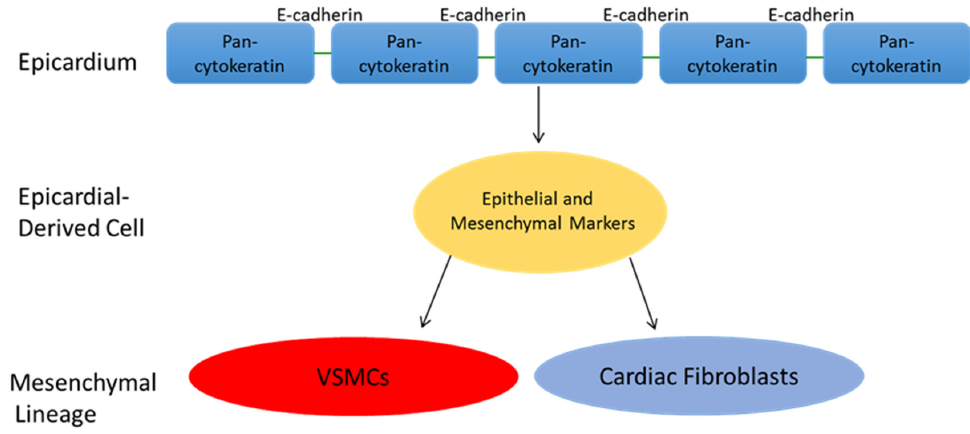
Figure 1. Epicardial EMT features the generation of Epicardial Derived Cells (EPDCs) that co ‐ express both epithelial and mesenchymal markers. This multipotent intermediary cell then goes on to adopt a mesenchymal lineage. There is agreement that EPDCs differentiate into vascular smooth muscle cells (VSMCs) of the coronary vasculature, as well as interstitial and peri ‐ vascular fibroblasts. However, the extent to which they differentiate into cardiomyocytes and endothelial cells, if they do at all, is controversial.